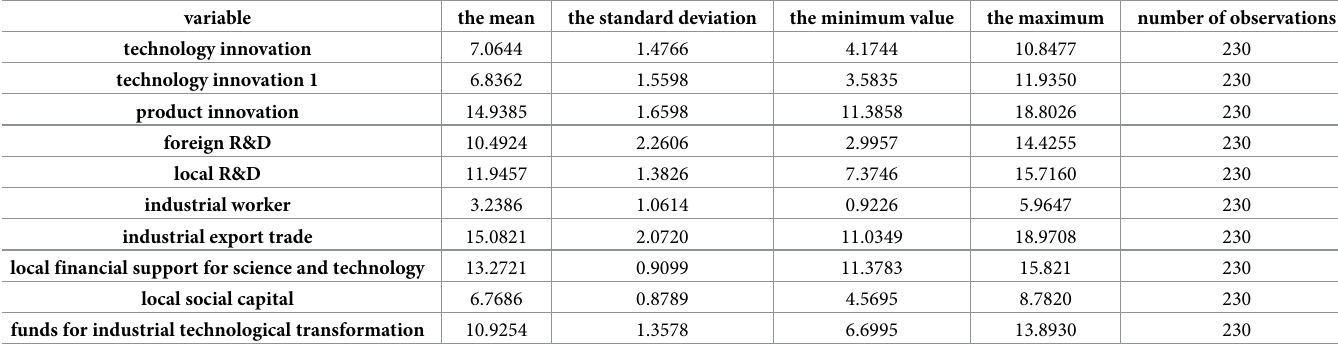
Table 1. Descriptive statistics of each variable.